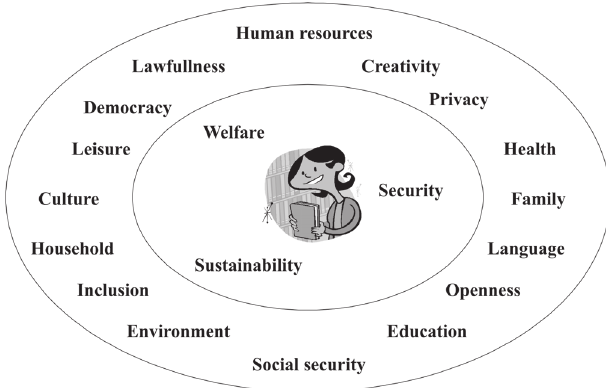
Fig 7. Quality of life as the goal for development: aspects The family is the cornerstone of our society, and it plays an enormously important role in generational solidarity and consolidation of the society. On a large scale the cohesion of society reduces the stratification of society on the basis of the principle of equal opportunities and participation, involvement of all members of society, obtaining benefits by each and every